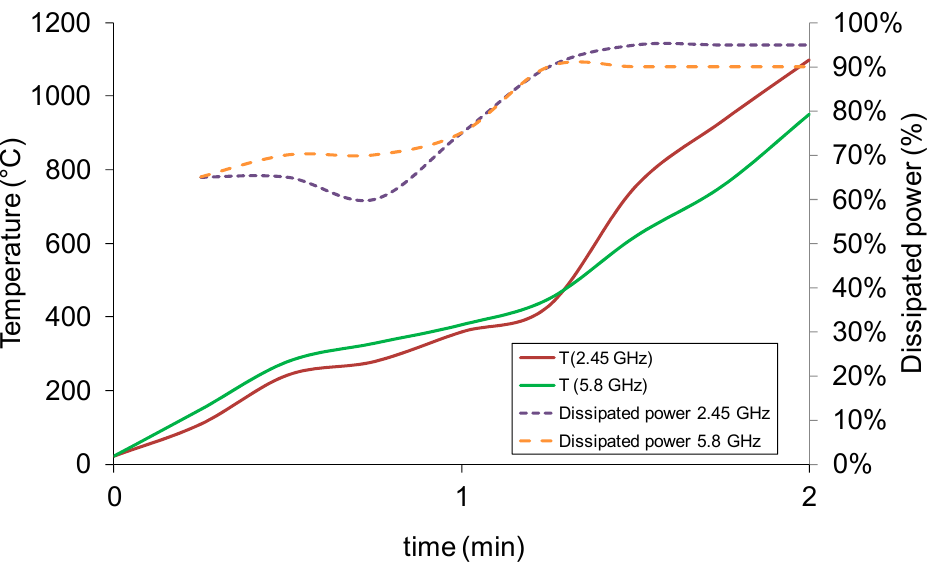
Figure 1. Heating curve (T prefix, continuos line) and dissipated power (dotted line) of the load obtained from 3.3 g of precursors, 200 W forward power, microwave-heated in single mode applicators.